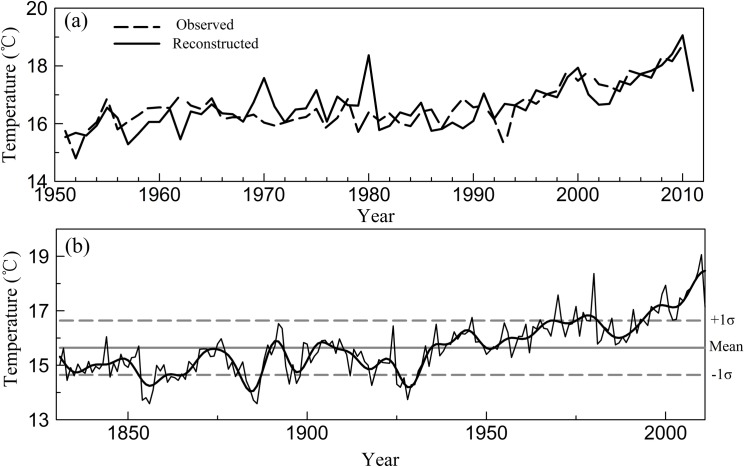
The observed and reconstructed May–October mean temperature (T510).(a) Comparison between observed and reconstructed T510 for their common period of 1951–2011 and (b) T510 reconstruction for Mt. Dongda since 1831. The thick line in (b) shows the smoothed data with a 10-year low-pass filter. The solid horizontal line represents the long-term mean for the period of 1831–2011; the dashed horizontal lines represent the mean value ± 1σ.